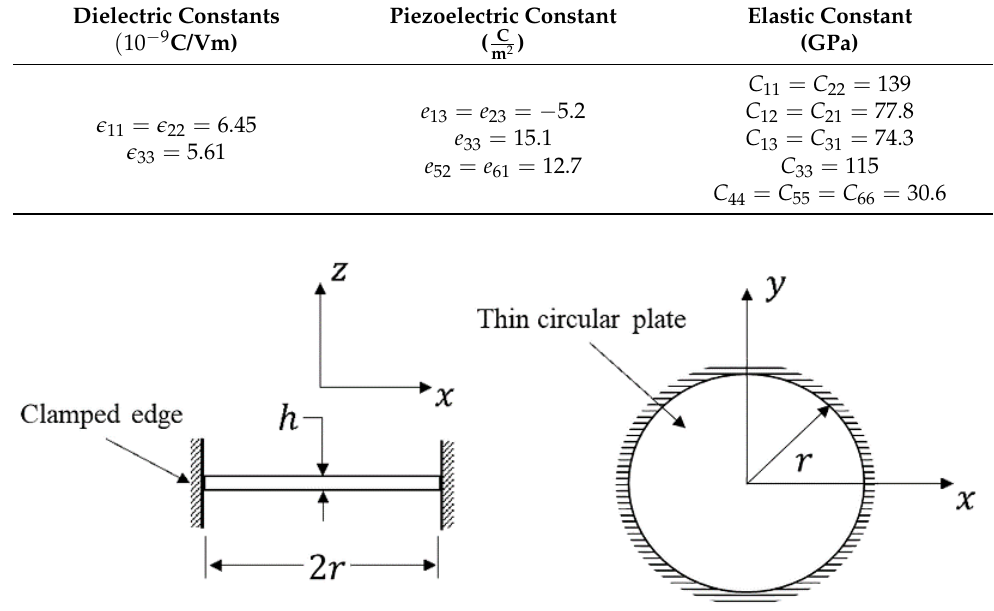
Figure 3. Clamped circular plate used for the FEM study.